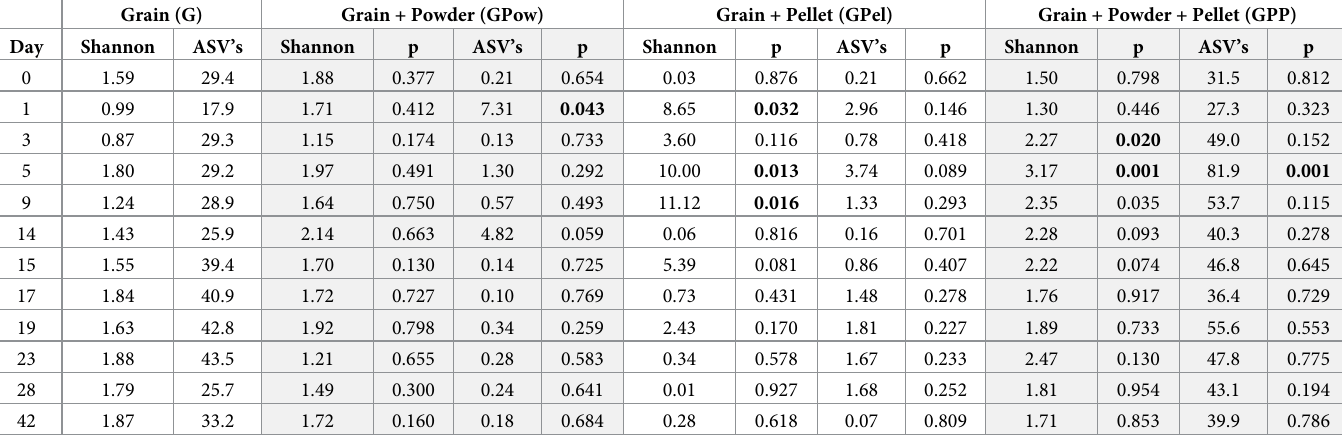
Table 2. Alpha diversity (Shannon’s H and number of Amplicon Sequence Variants (ASV’s) in fecal samples of Birmingham Roller pigeons exposed to different probiotic treatments. Diversity metrics that differed significantly from the control Grain treatment are bolded. Significance level was determined at α = 0.05. Grain